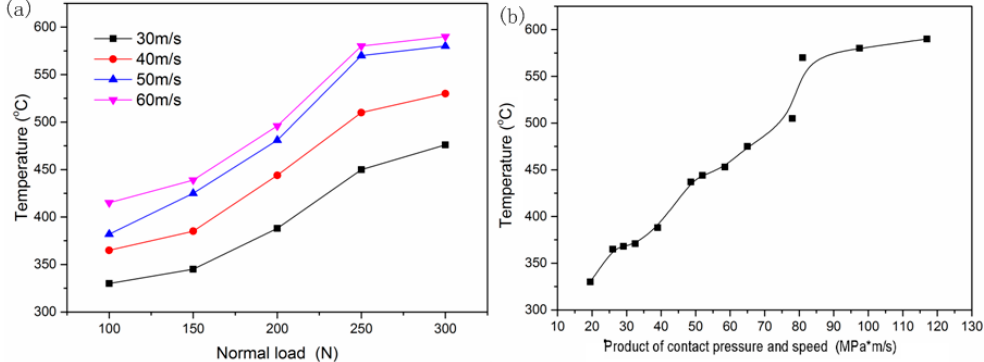
Figure 6. The temperature of contact surface: ( a ) at various loads vs. ( b ) the product of contact pressure and speed.